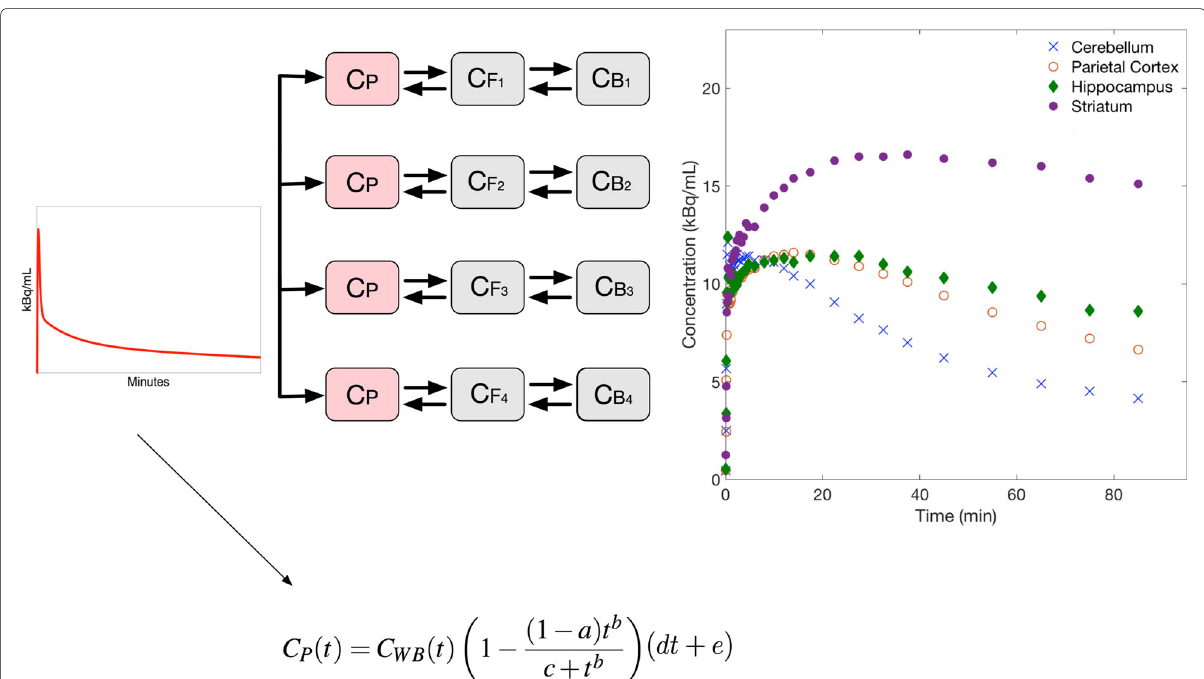
Fig. 1 Constrained SIME model used in the analysis. C P represents the AIF, C F represents the free state and C B of the 2-TC model. The C P was modelled as a product of plasma to whole blood ratio and the Hill function. Three parameters of the Hill function ( a , b , c ) and two parameters of the straight line function ( d , e ) were optimised simultaneously by fitting N (where N = 4) TACs extracted from different brain regions. C WB is derived from PV-corrected PET images. TACs derived from the cerebellum, parietal cortex, hippocampus and striatum from one subject are shown on the